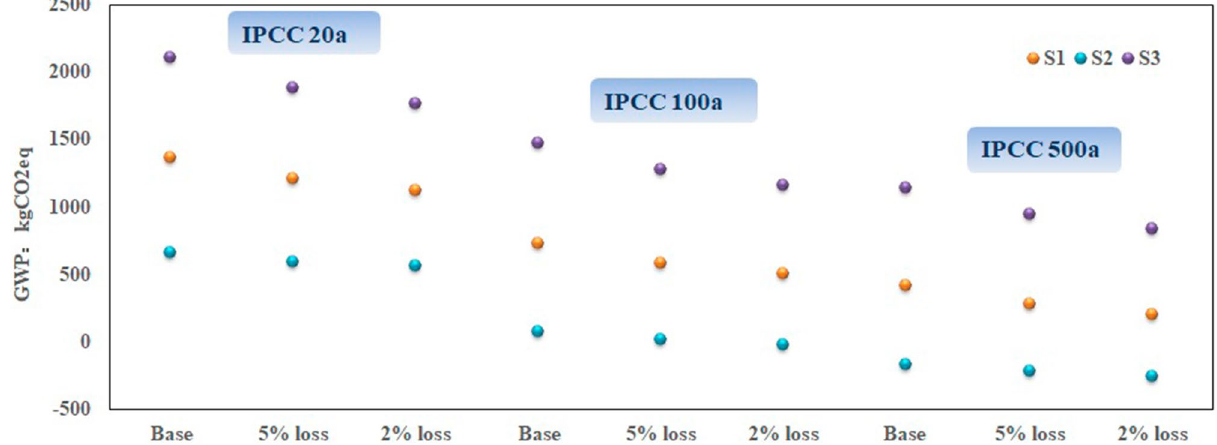
Figure 5. The sensitivity results of each system in IPCC assessment method under different situations of change in silage mass loss ratio.